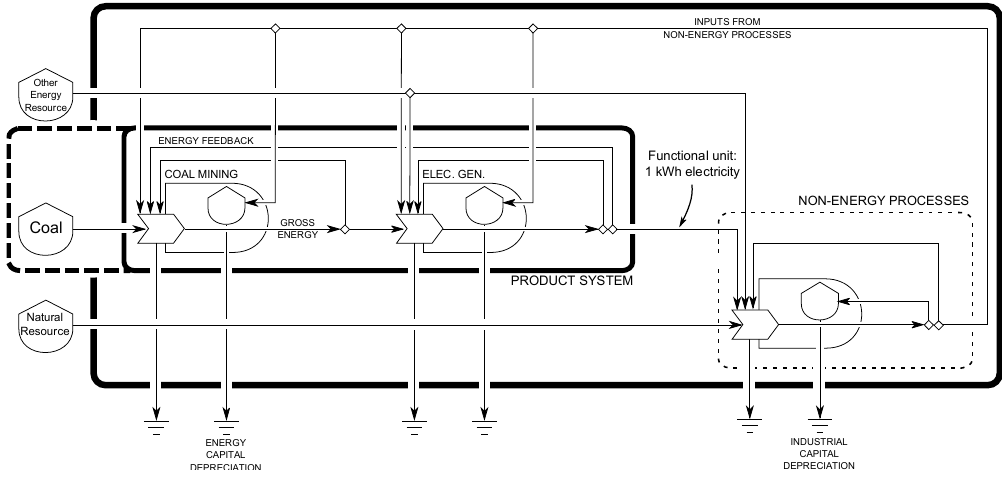
Figure 4. System diagram for a model of electricity from coal.